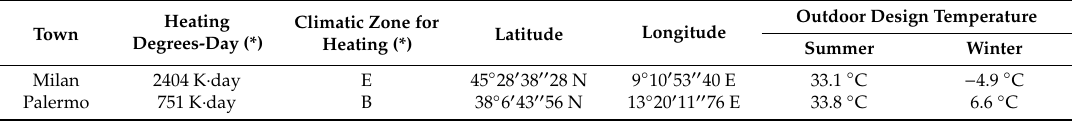
Table 2. Geographic and climatic conditions of the selected towns, from ASHRAE [37] and DPR 412 / 93 [48].